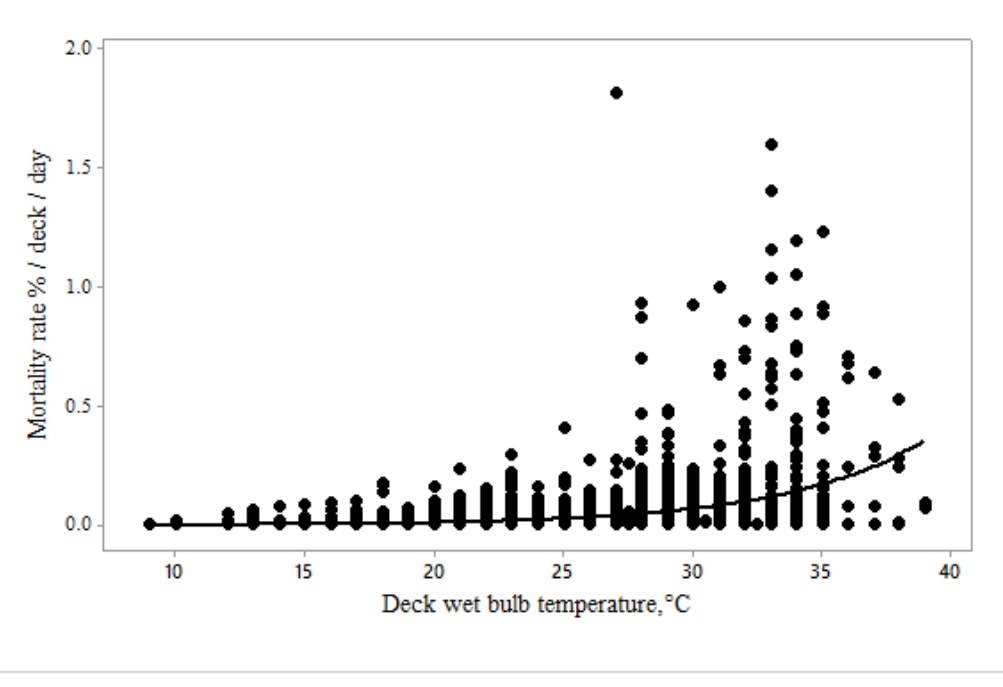
Figure 9. Mortality rate changes with deck wet bulb temperature °C ( n = 2638). The relationship between mortality rate %/day and deck T WB was described by the equation: Mortality rate %/deck/day = 0.0003 (±0.000009) × exp 0.18(±0.0095) Deck T WB , F = 8.85, p < 0.0001 (Equation 7).